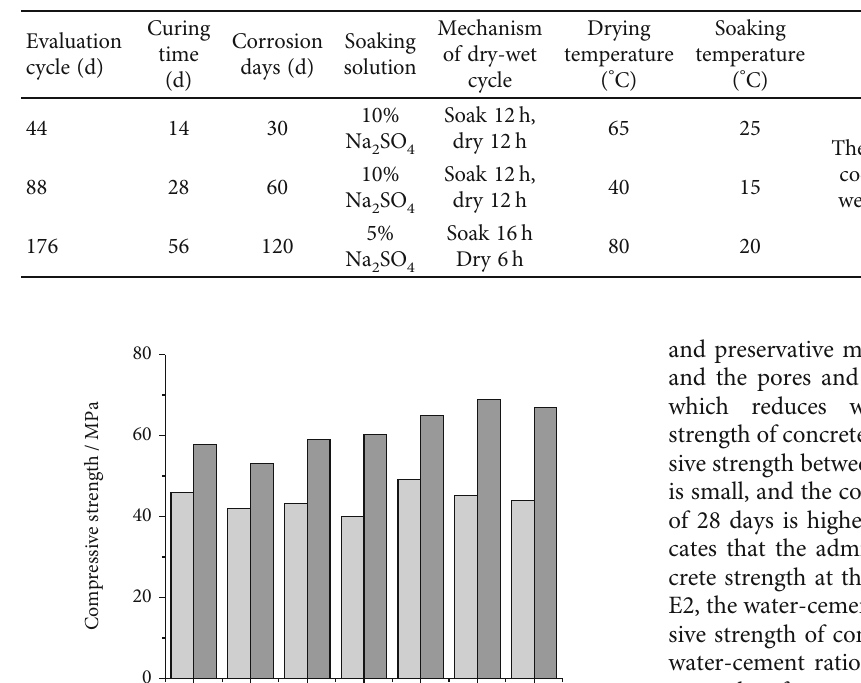
Table 5: Accelerated test system of pile foundation concrete.